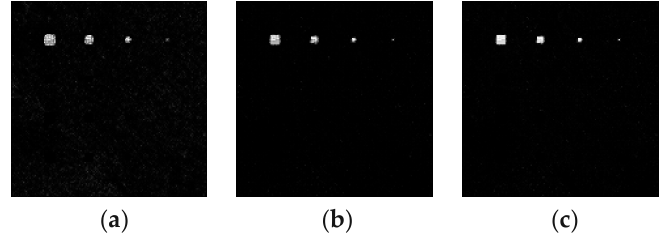
Figure 19. ( a ) The false color sense of Cuprite data (bands 160, 100, 40). ( b ) The spectra used to construct targets. ( c ) the synthetic data. ( d ) The ground truth. ( e ) The legend of different targets.